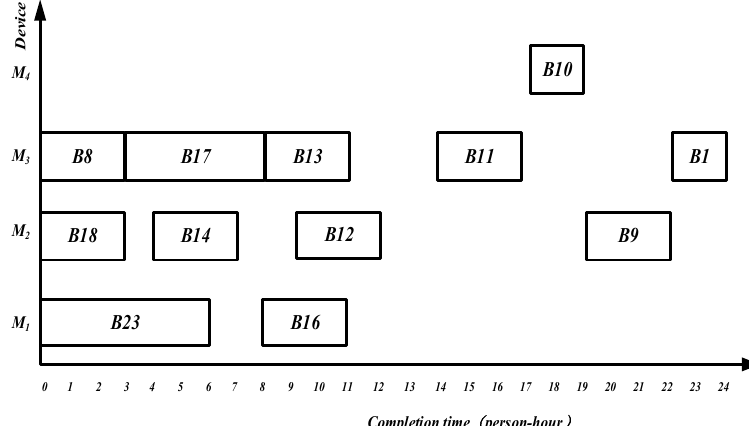
Figure 17. Gantt chart obtained by the PBP for workshop f 1 with 24 person-hours.